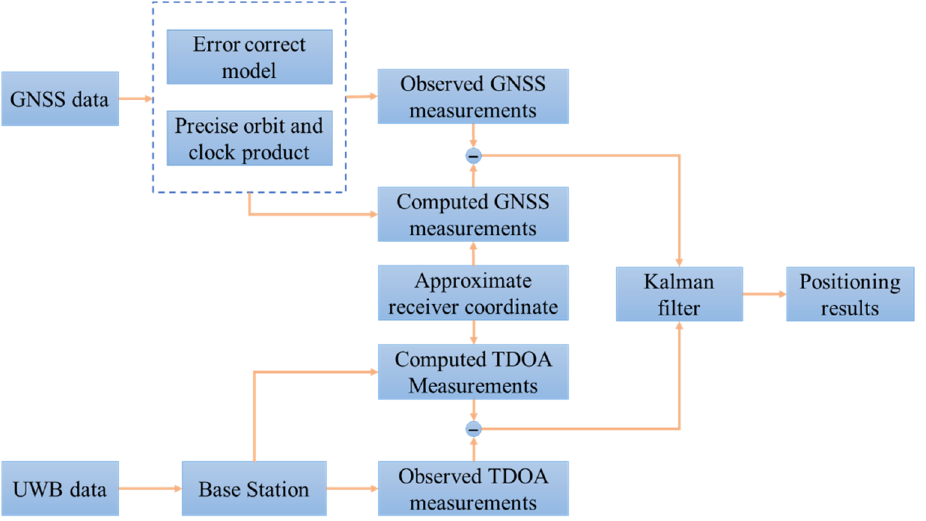
Figure 1. Framework of Global Navigation Satellite System (GNSS)/Ultra-wideband (UWB) tightly coupled integration algorithm.